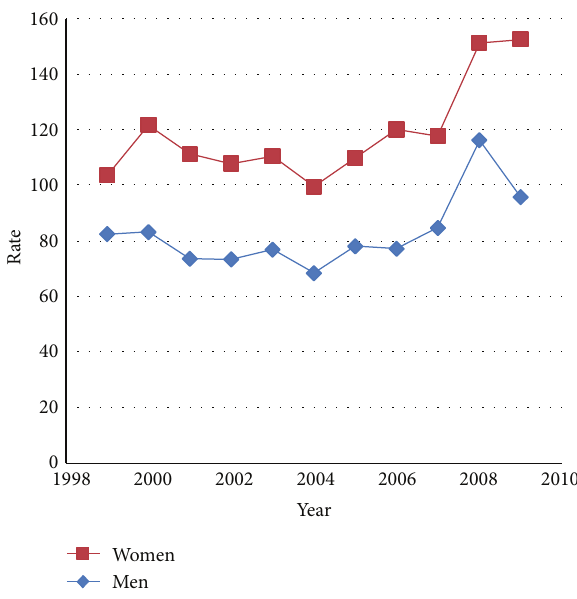
Figure 2: Estimated annual rate per 100,000 population of all-listed diagnoses of pulmonary hypertension by year and sex: National Hospital Discharge Survey, United States,